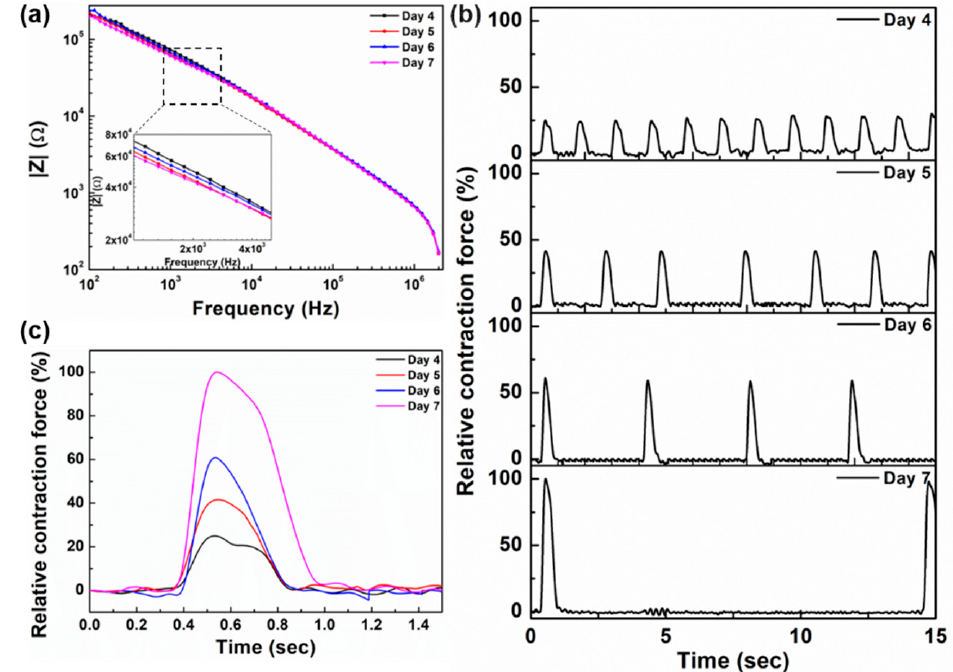
Figure 5. ( a ) Bode plot of the impedance spectrum measured from day 4 to day 7 after cell seeding, ( b ) normalized contraction force from day 4 to day 7 after cell seeding, ( c ) overlapped curves of contraction force from day 4 to day 7.